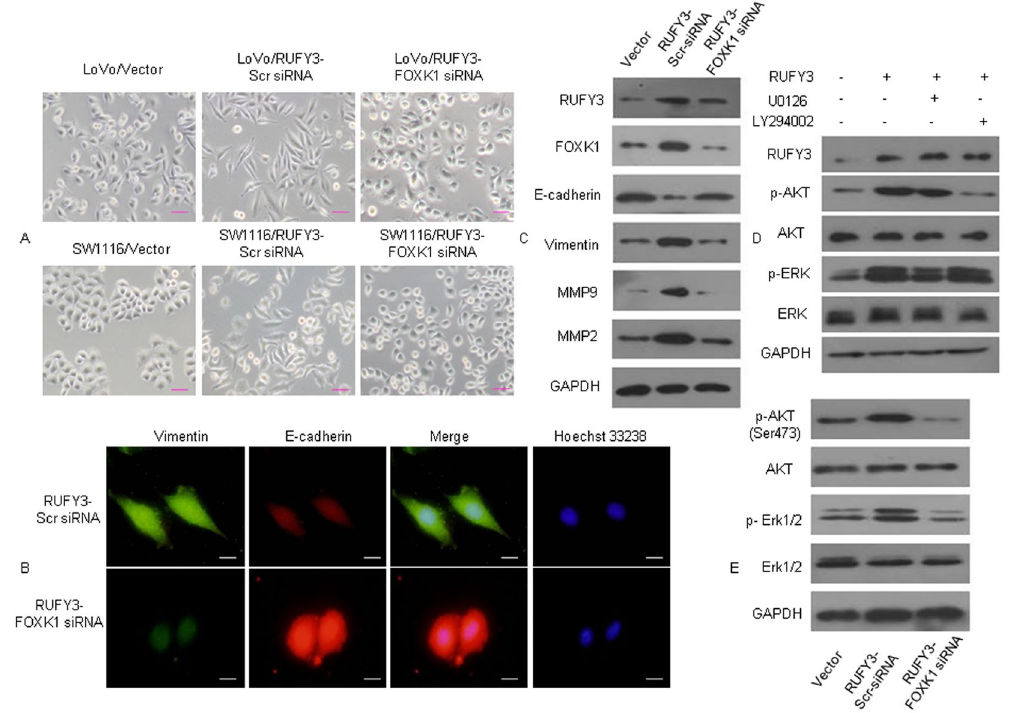
Figure 5. FOXK1 regulates EMT in vitro . ( A ) Morphology of pooled stable transfectants of Vector, RUFY3, and RUFY3-FOXK1 siRNA, as visualized under a phase-contrast microscope. ( B ) Immunofluorescence and microscopic visualization of E-cadherin (red) and vimentin (green) staining in RUFY3-scr-siRNA and RUFY3- FOXK1-siRNA cells. ( C ) The EMT biomarkers, including E-cadherin, vimentin, MMP2 and MMP9, were detected by western blot. ( D ) Western blot analyses of pooled stable transfectants with vector and RUFY3, examining p-ERK and p-Akt expression in LoVo cells treated with U0126 or LY294002. ( E ) Decreased FOXK1 expression inhibited the AKT/ERK/EMT signaling pathway, as detected using western blot analysis. Scale bars represent 50 μ m in ( A ) and 20 μ m in ( B ). The results were reproduced in three independent experiments. The full-length blots/gels are presented in Supplementary Figure